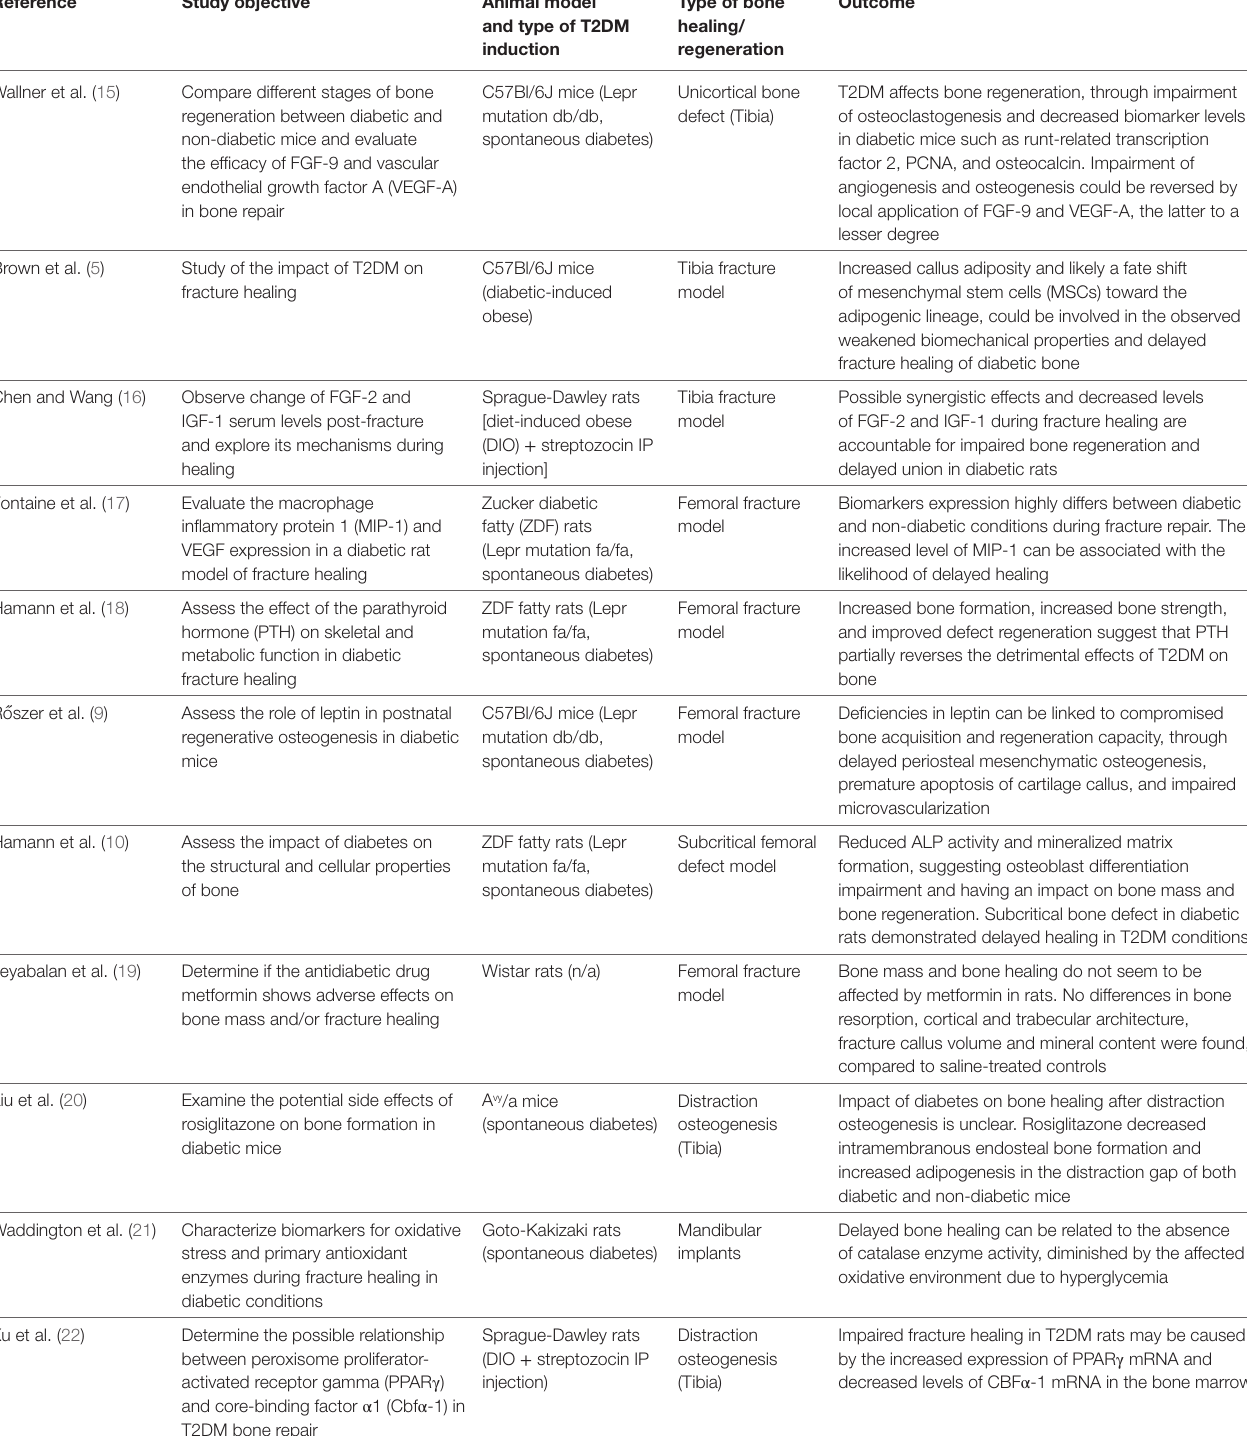
TaBle 2 | Animal studies on bone healing in type 2 diabetes mellitus (T2DM) published between January 2007 and March 2017 (in descending order).